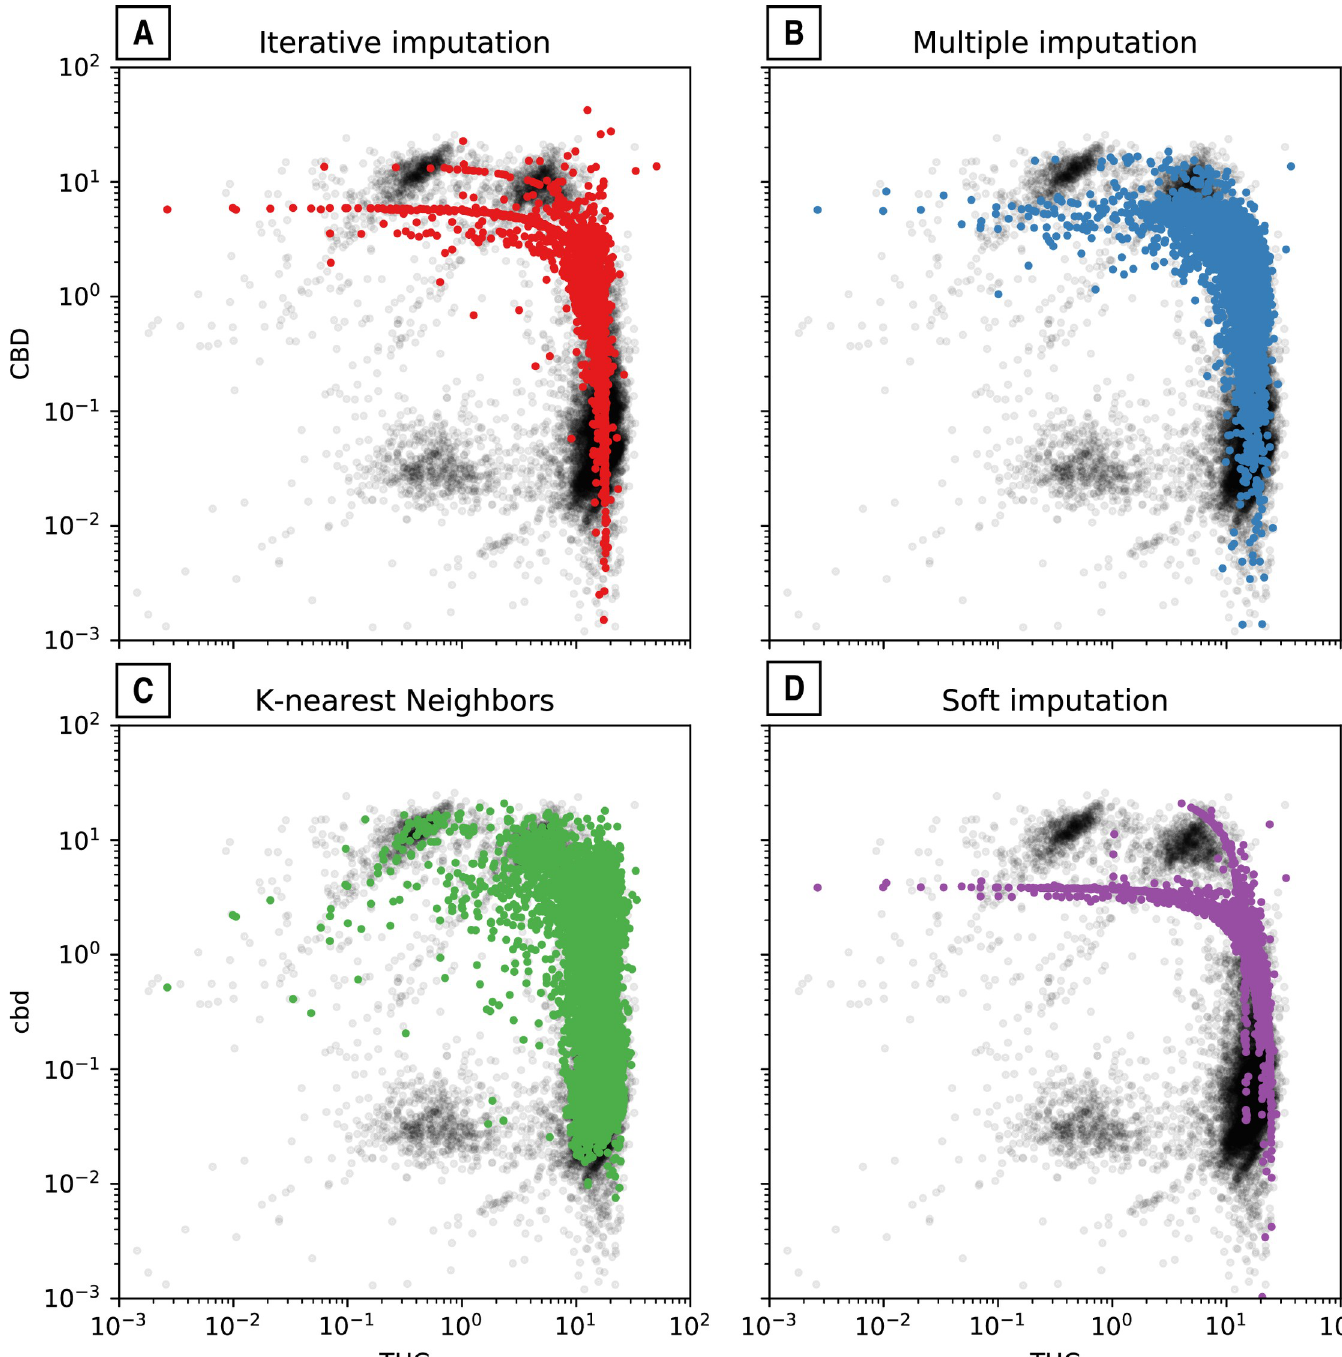
Fig 5. Original vs. imputed values using four methods. The 191 imputed values from each of the four methods, compared to the raw distribution on Fig 3. https://doi.org/10.1371/journal.pone.0236878.g005 three kinds of regression models on four kinds of imputation methods. The goal of this analy- sis is to identify if a particular combination of regression modeling and data imputation reli- ably models multiple kinds of cannabinoid abundance as a function of other cannabinoids. No